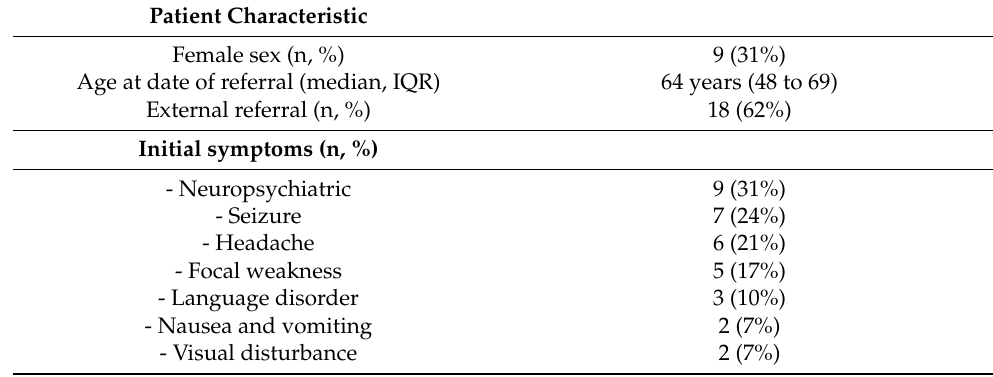
Table 1. Patient baseline characteristics at the time of first referral to the MDTM. Patient